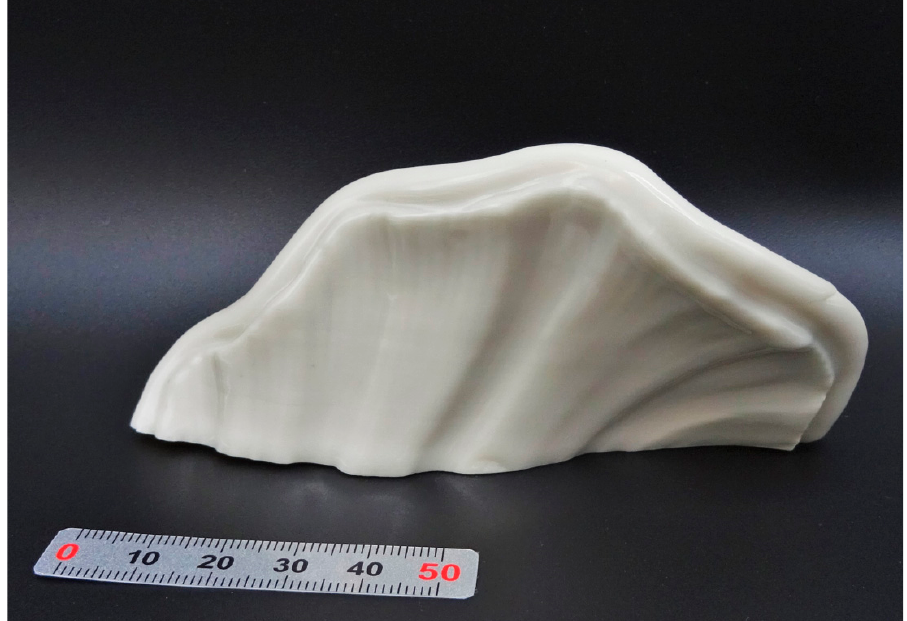
Figure 19. Sintered and glazed fragment, clockwise manufactured, the twisted baseplate is clearly visible in the left corner.